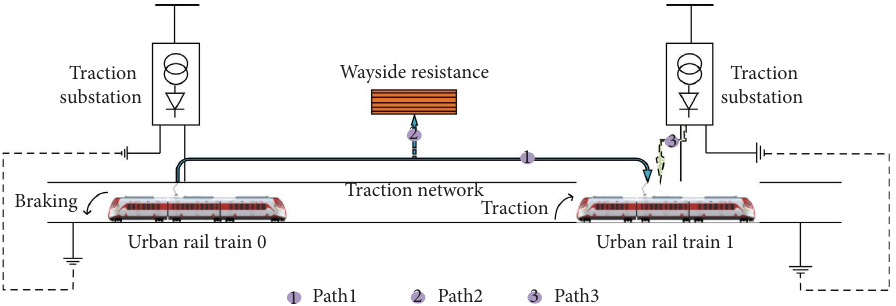
Figure 1: Schematic diagram of regenerative energy utilization